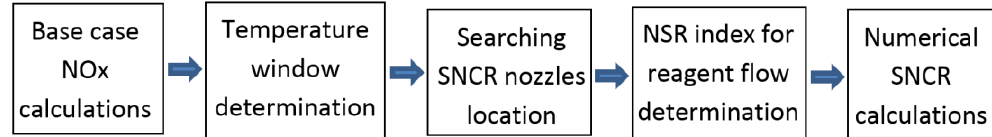
Figure 1. Block diagram for the base procedure for modeling approach of combustion process.